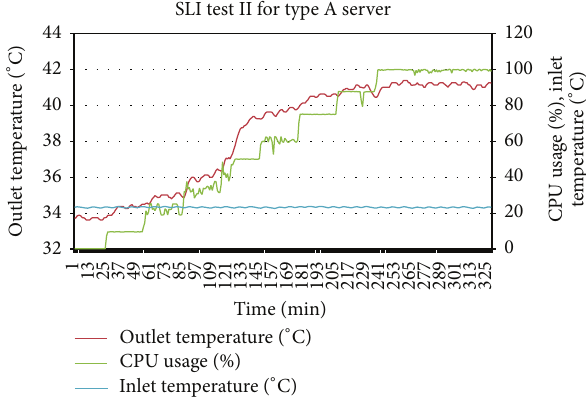
Figure 5: SLI test performed for thermal profiling of type B server. Table 4: Thermal profile elements calculated from SLI tests.